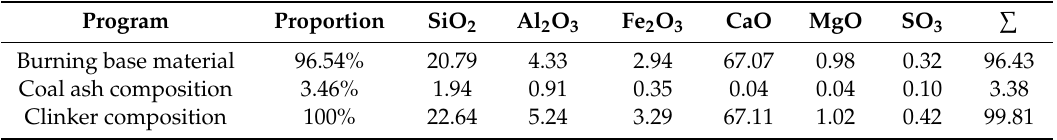
Table 7. The calculated value of the clinker